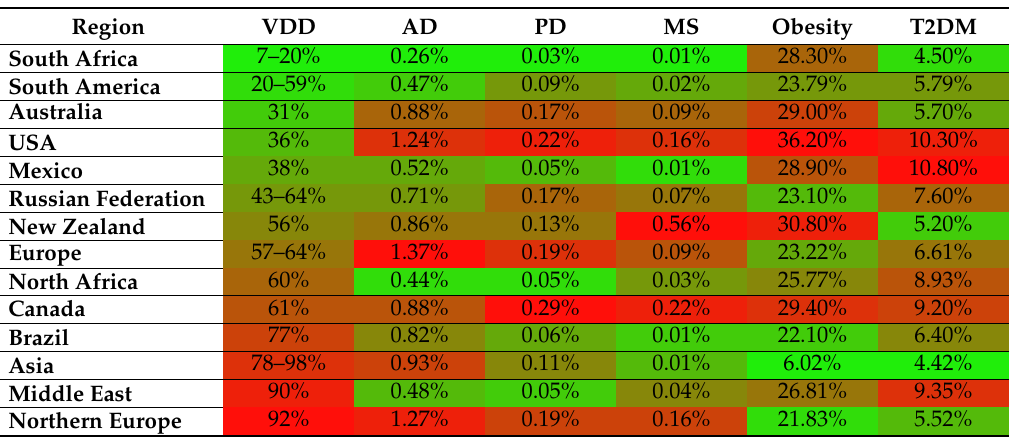
Table 1. Global prevalence of vitamin D deficiency and other